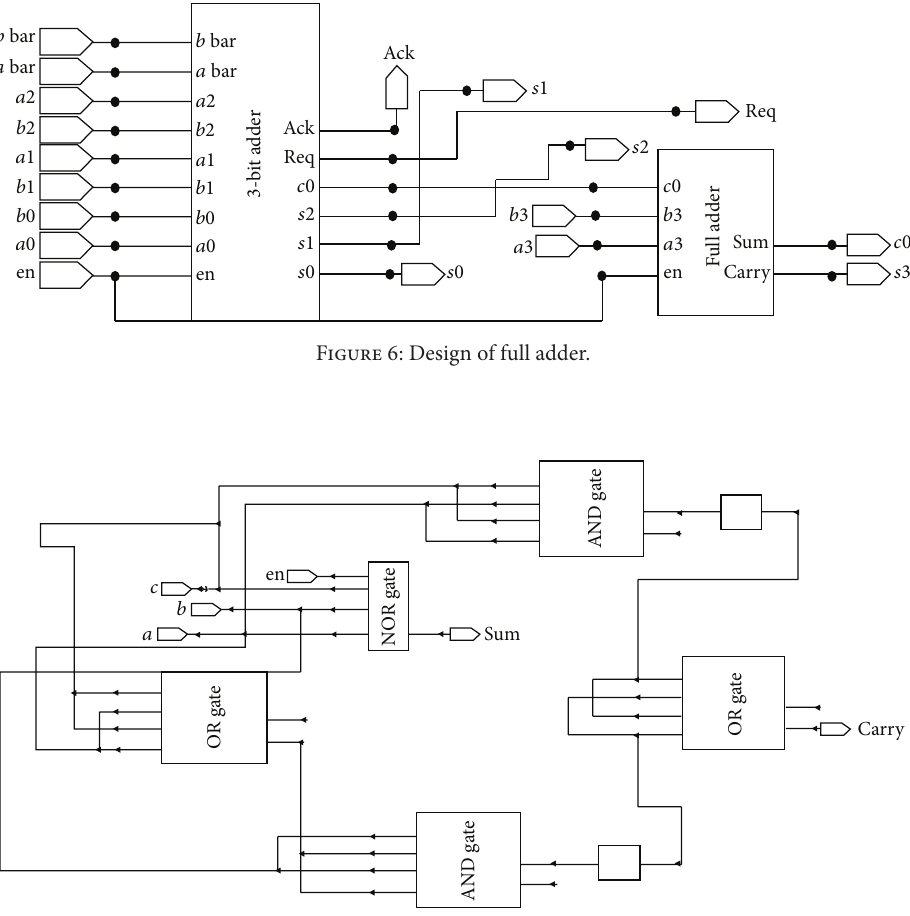
Figure 7: Design of 4-bit ripple carry